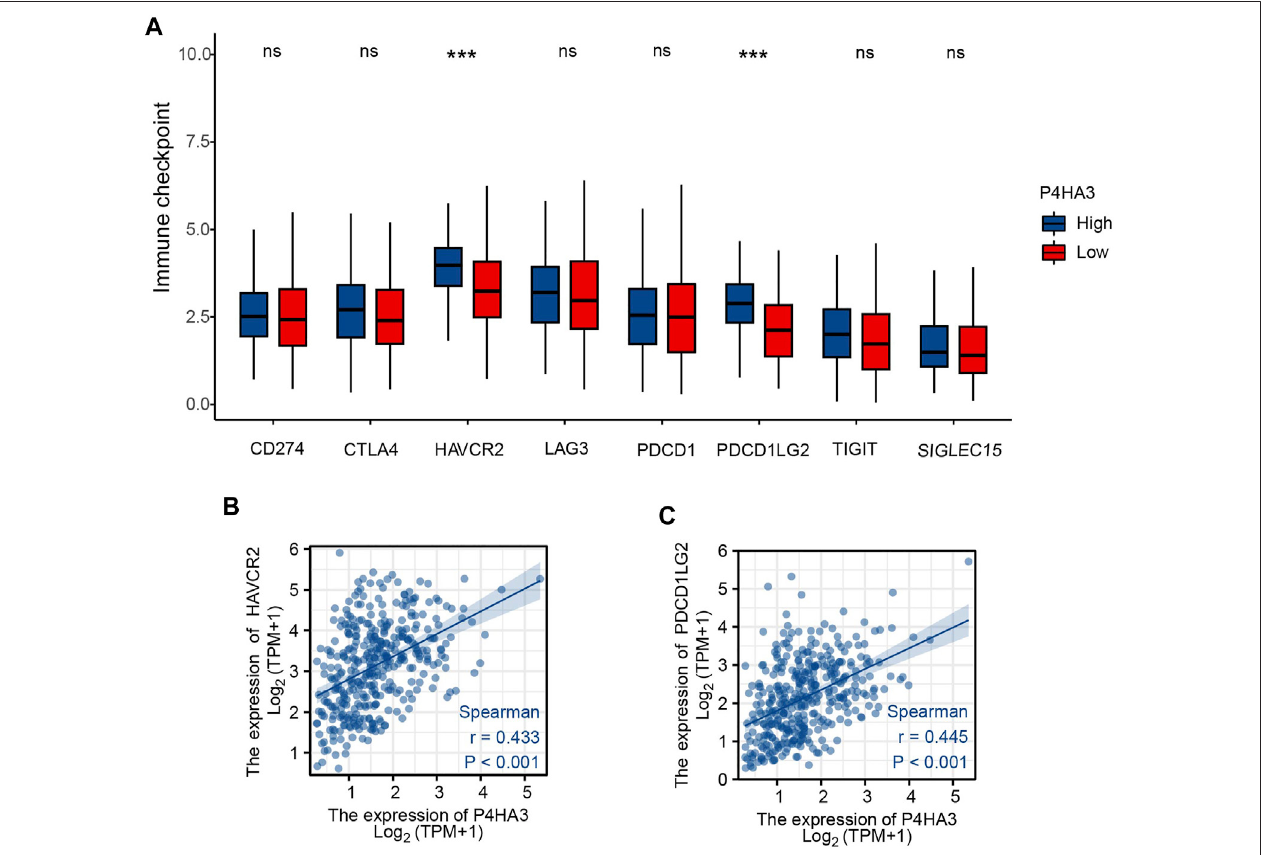
FIGURE7|(A) Differentialexpression ofimmune-checkpoint – relevant genesinlowand high P4HA3-expressinggroups. (B) P4HA3 waspositively correlated with HAVCR2. (C) P4HA3 was positively correlated with PDCD1LG2. ns, p > 0.05; ***, p < 0.001. Abbreviations: HAVCR2, hepatitis A virus cellular receptor 2; PDCD1LG2, programmed cell death 1 ligand